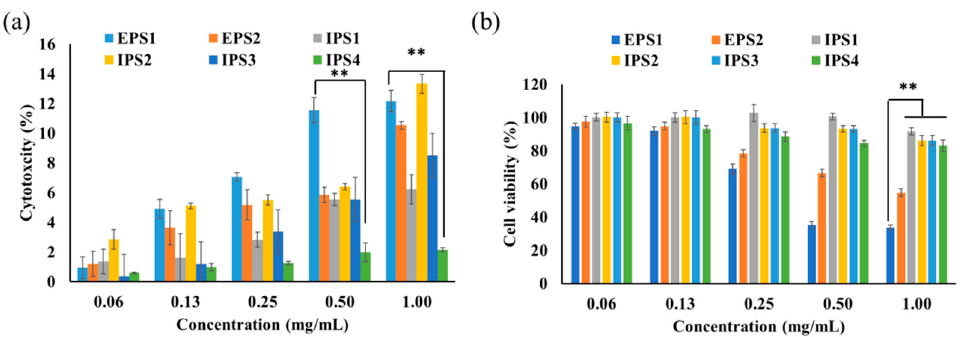
Figure 6. Cytotoxicity of polysaccharides (EPSs and IPSs) isolated from Trichoderma spp. in a noncancerous murine fibroblast (NIH3T3) cell line ( a ) and a human triple-negative breast cancer (MDA-MB231) cell line ( b ). Results presented as mean ± SE (DF-2), ** p < 0.01 indicates the signifi- cance between the polysaccharides and their low concentration.